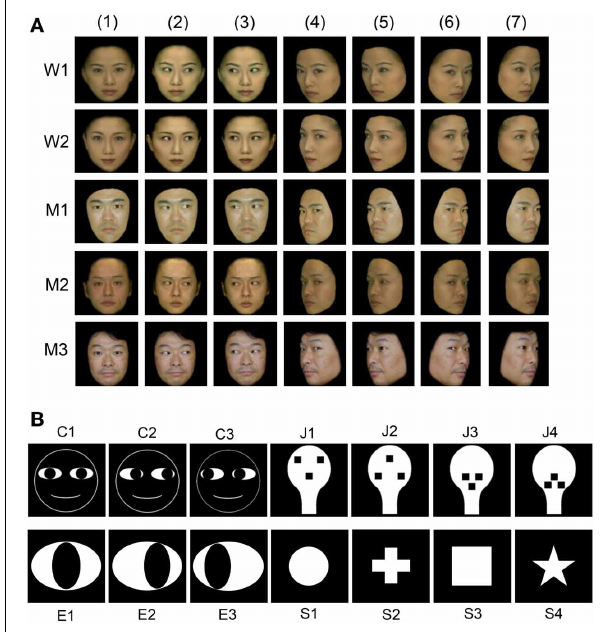
FIGURE 1 | Visual stimulus set used in the present study. (A) Thirty-five facial photos of 5 different models, including 2 females (W1 and W2) and 3 males (M1, M2, and M3). The stimulus set for each model consisted of 7 faces with the following different head orientations and gaze directions: (1) frontal view with direct gaze; (2) frontal view with gaze to the right; (3) frontal view with gaze to the left; (4) left profile view with direct gaze; (5) left profile view with indirect gaze; (6) right profile view with direct gaze; and (7) right profile view with indirect gaze. (B) Fourteen artificial schematics, including 3 cartoon faces (C1–3) with three gaze directions, four face-like patterns (J1–4), three eye-like patterns with three gaze directions (E1–3), and four simple geometric patterns consisting of a circle, cross, square, and star (S1–4).